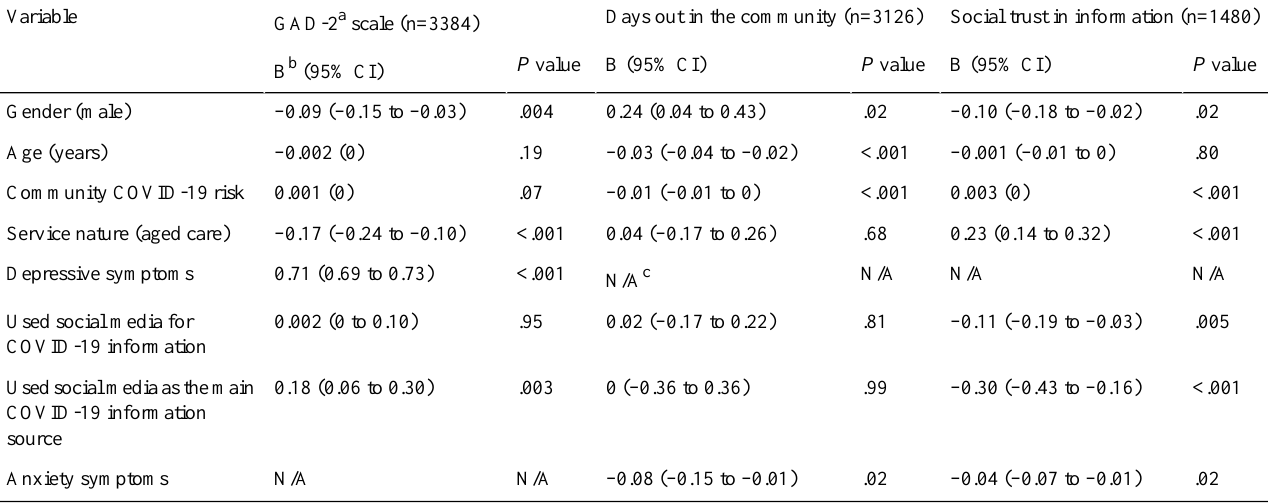
Table 2. Results from ordinary least squares regressions predicting anxiety symptoms, days out in the community, and social trust in information.